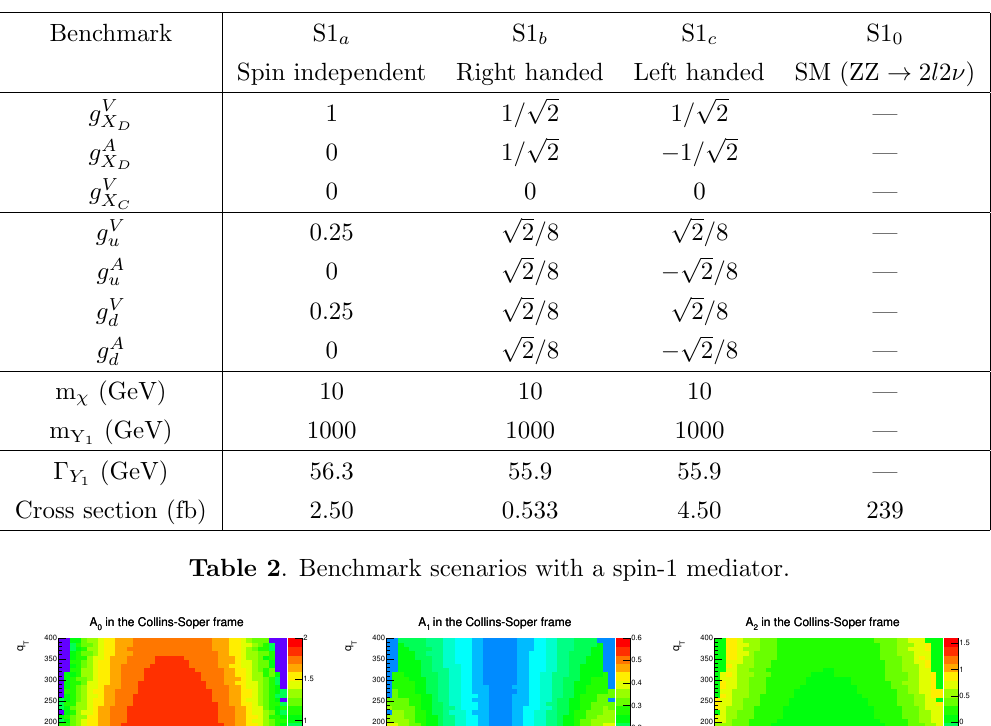
A 4 and the y Z q T di(cid:11)erential cross section of the benchmark (cid:0) (cid:0)